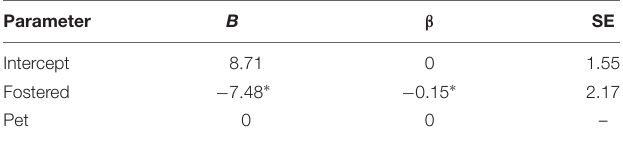
TABLE 12 | Standardized and unstandardized regression coefficients for each predictor in the significant model of the backward deletion multiple regression for “no choice” outcome.